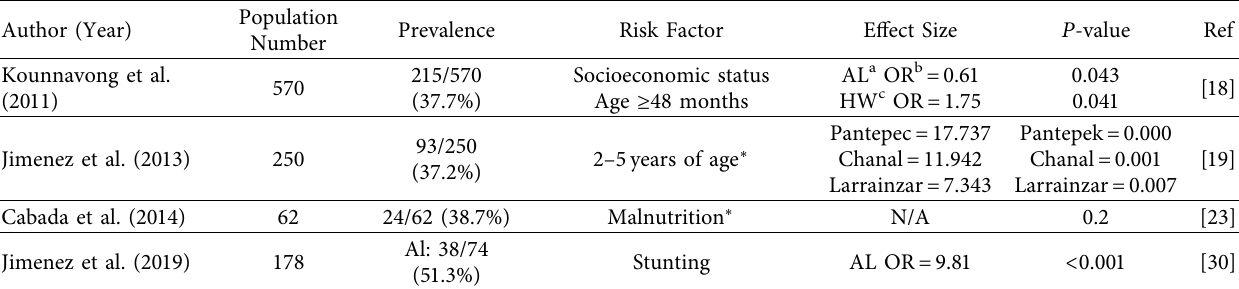
Table 5: Summary of risk factors for STH infection in various